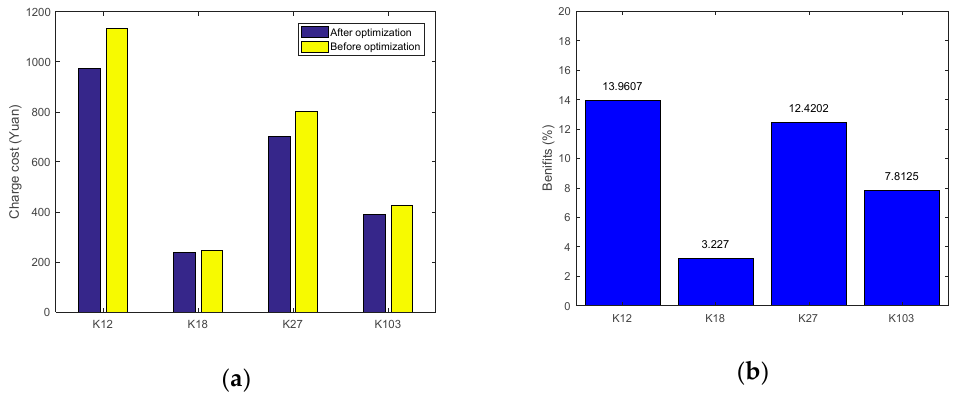
Figure 10. ( a ) Charging cost before and after optimization under different cases; ( b ) The percentage of optimal benefits in different cases.